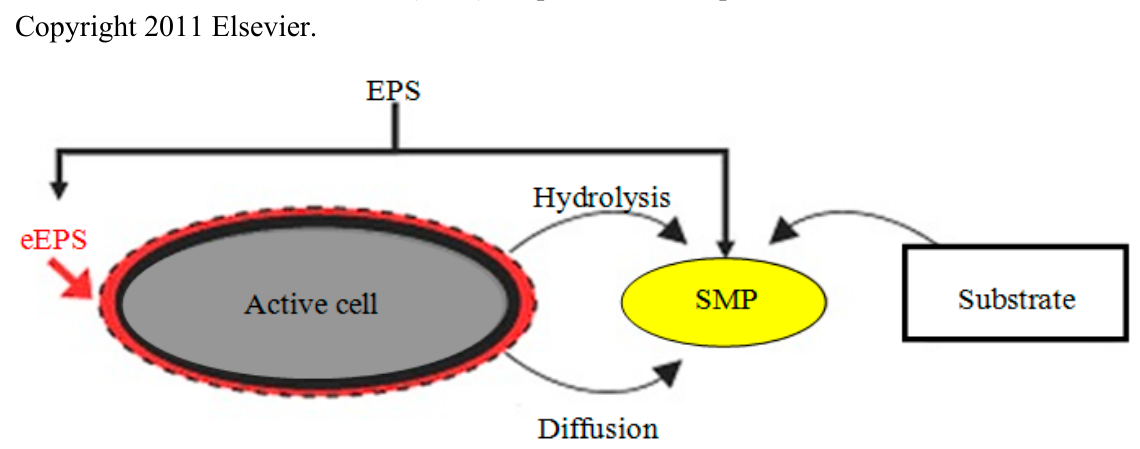
Figure 3. Simplified representation of extracted extracellular polymeric substances (eEPS) and Soluble Microbial Products (SMP). Reproduced with permission from Reference